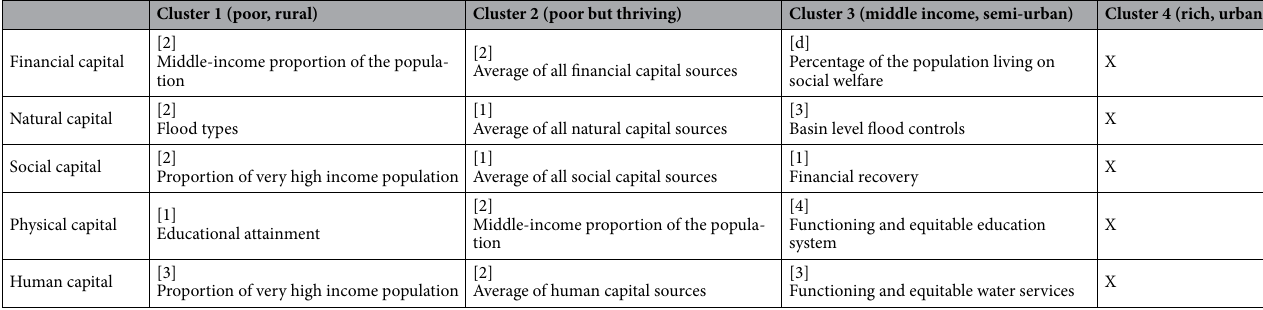
Table 3. Summary of capitals and cluster related BRT results: each cell shows (i) the total number of sources found which had a significant predictive power (in square brackets) and (ii) the most important source of resilience within the best BRT